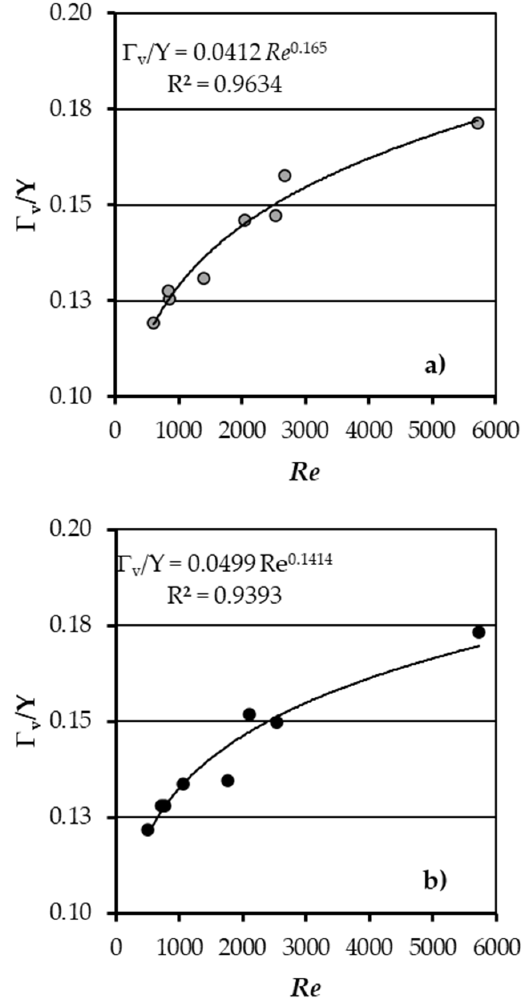
Figure 5. Comparison between the experimental pairs ( Re , Γ v / Y ) and Equation (12), with a = 0.0412 and e = 0.165 for BC = 6 kg m − 2 ( a ) and a = 0.0499 and e = 0.1414 for BC = 12 kg m − 2 ( b ).